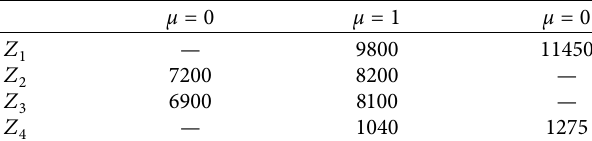
Table 8: Upper and lower bounds of objective function.